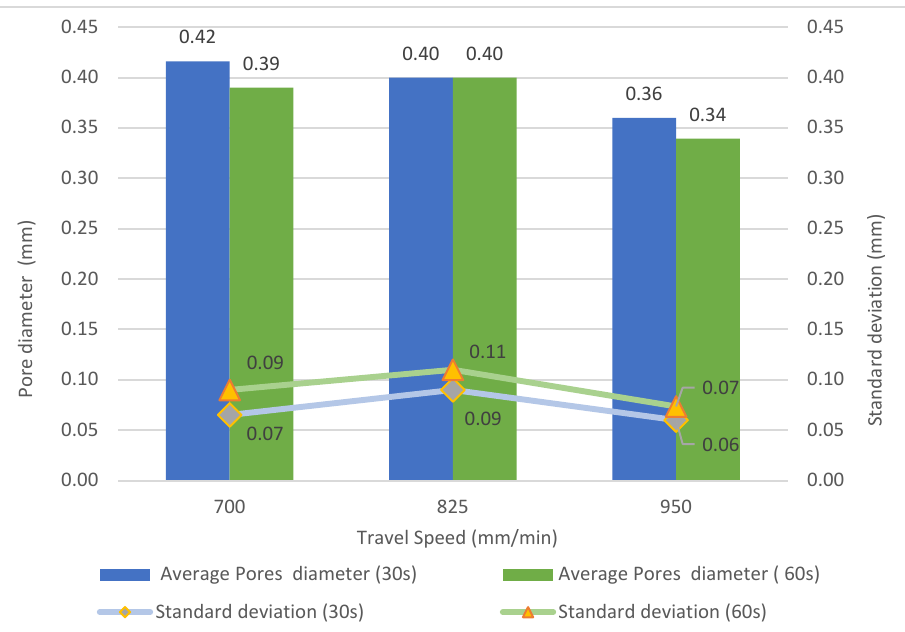
Figure 6. Mean pore diameter and its standard deviation versus travel speed for cooling times of 30 and 60 s.